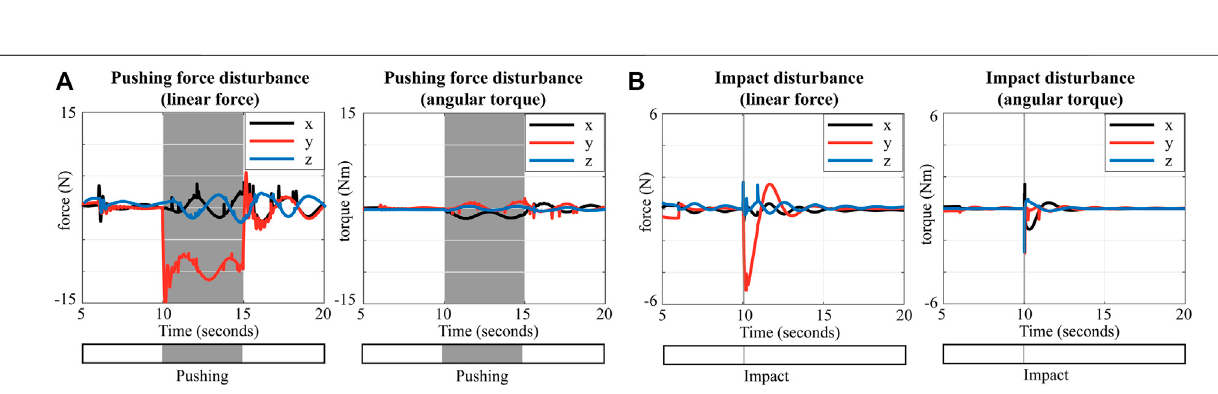
FIGURE 7| IAE values corresponding to simulation results with different levels ofexternaldisturbances: The simulation scenarios are those described in Sections 4.1.1 (A) , 4.1.2 (B) , and 4.1.3 (C) . To calculate the IAE values of the impact simulation (C) , we use the same time interval [10, 15] to cases (A , B) .